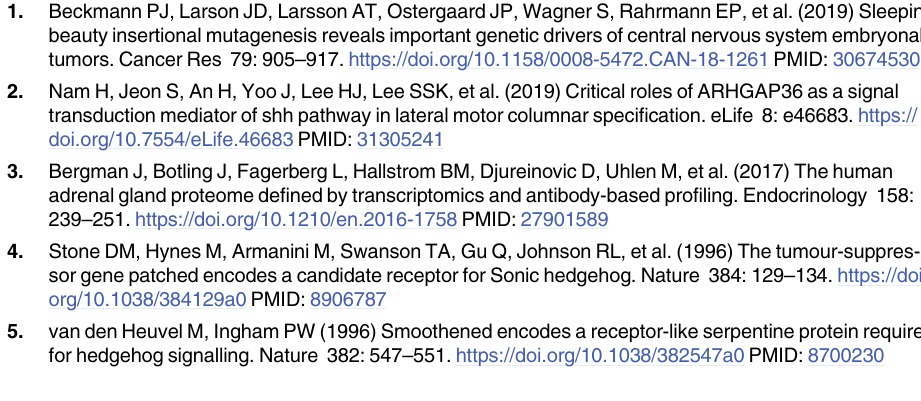
S1 Table. Antibody and primer resources. (XLSX) S1 Raw images. Original western blot images. (PDF)